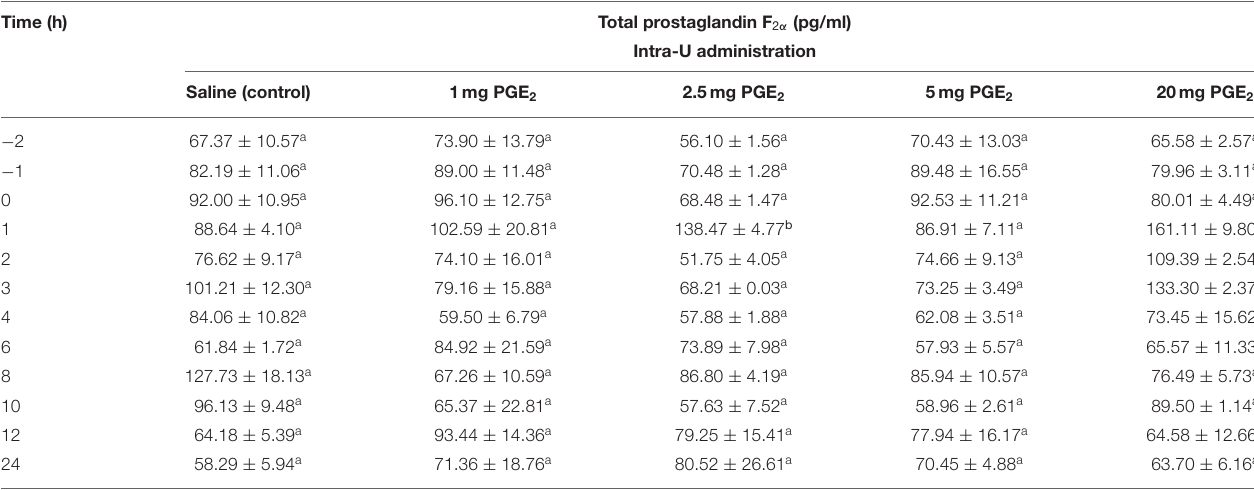
TABLE 2 | The effect of one intrauterine administration of prostaglandin (PG) E 2 on total prostaglandin F 2 α (the sum of PGF 2 α and PGF 2 α metabolite 13,14-dihydro-15-keto PGF 2 α –PGFM) concentrations in mares’ blood plasma samples ( n = 3 per dose) at day 10 of the estrous